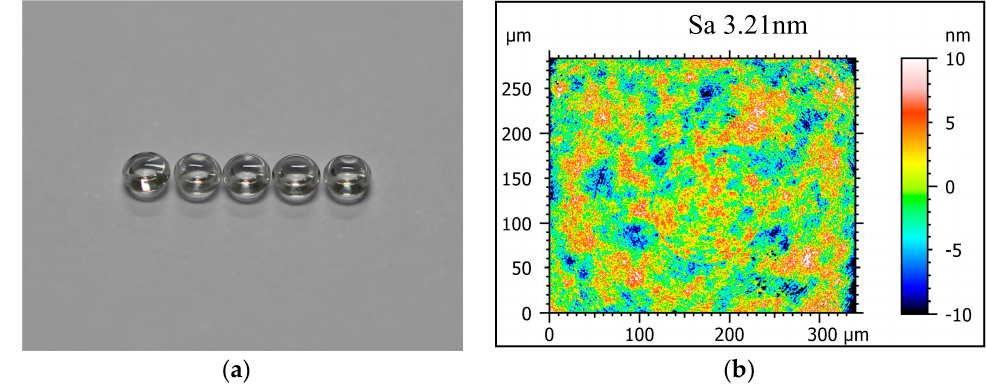
Figure 9. Molded lenses ( a ) the molded lenses, ( b ) the measured surface morphology of the central region.